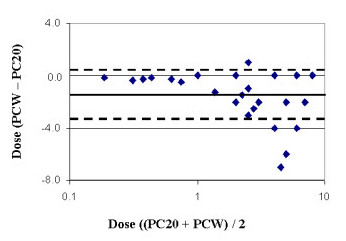
Analysis of the difference in dose values at end of test (PCW) and the dose at PC20, as compared with mean Dose values of the two, in a Bland and Altman analysis (20). Dotted lines represent 95% coefficient of variation values.